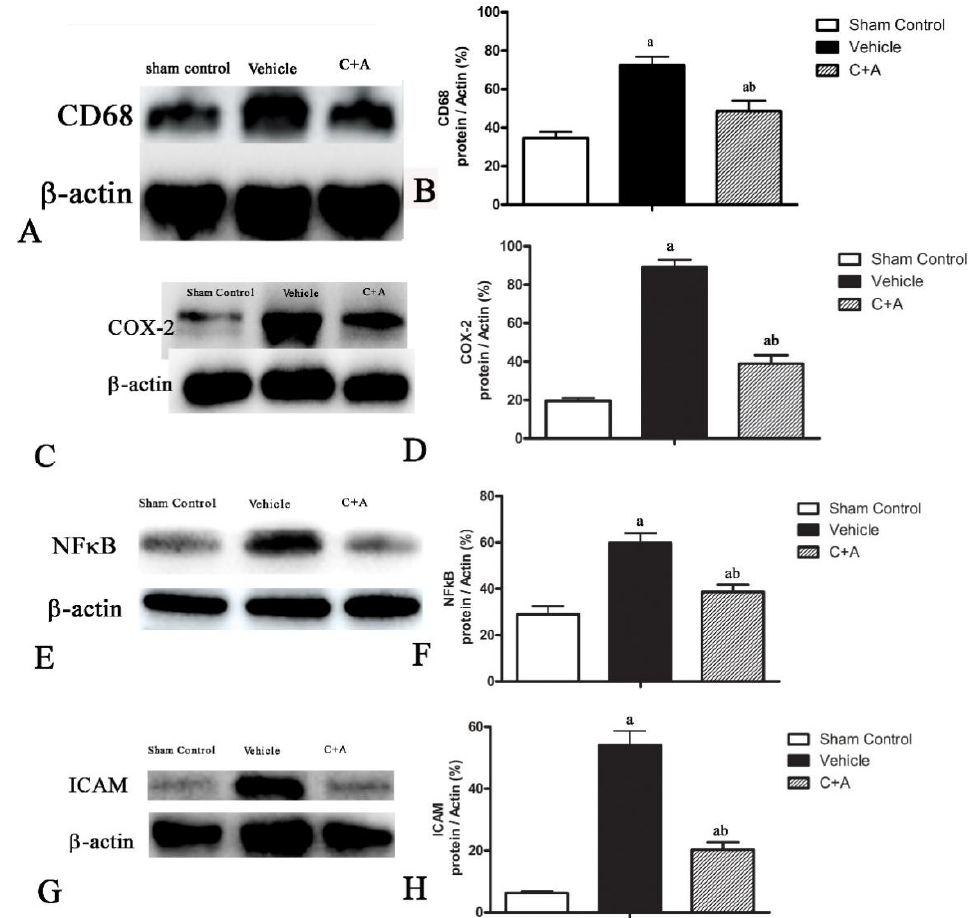
Figure 2. Western blot analysis of the expressions of ( A , B ) CD68/ED1, ( C , D ) cyclooxygenase-2 (COX-2), ( E , F ) nuclear factor kappa B (NF- κ B), ( G , H ) intercellular cell adhesion molecule-1 (ICAM-